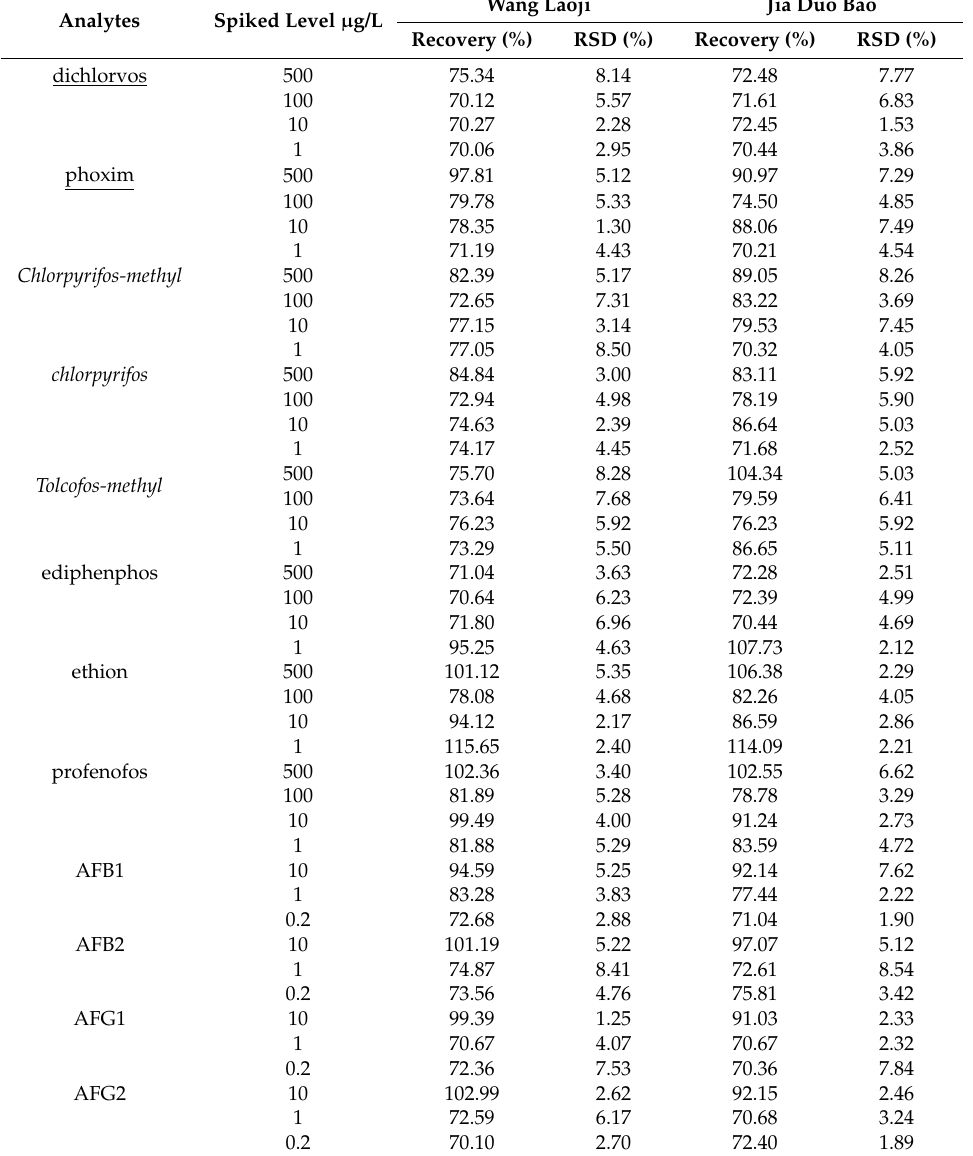
Recoveries of the OPPs and aflatoxins from herbal tea samples using optimized vortexed-assisted DLLME ( n =